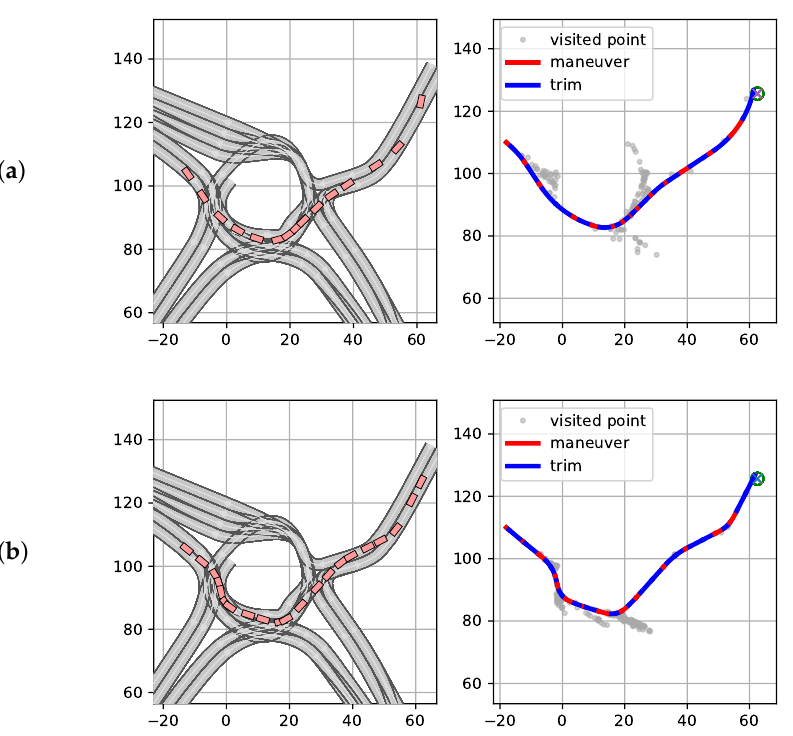
Figure 16. Trajectories for the automaton with 36 trims: ( a ) handcrafted; ( b )